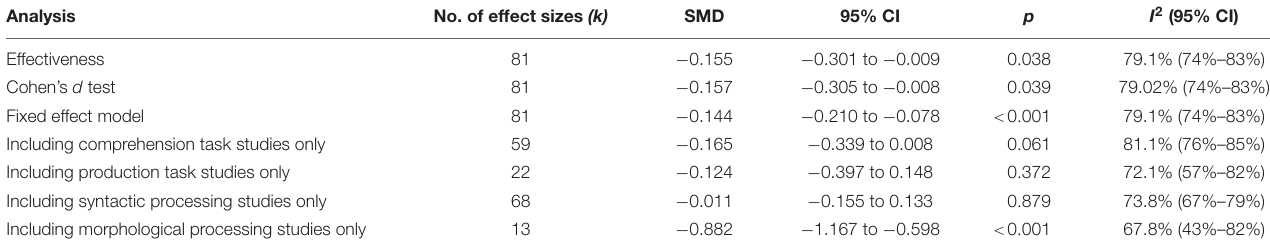
TABLE 2 | Sensitivity analysis.